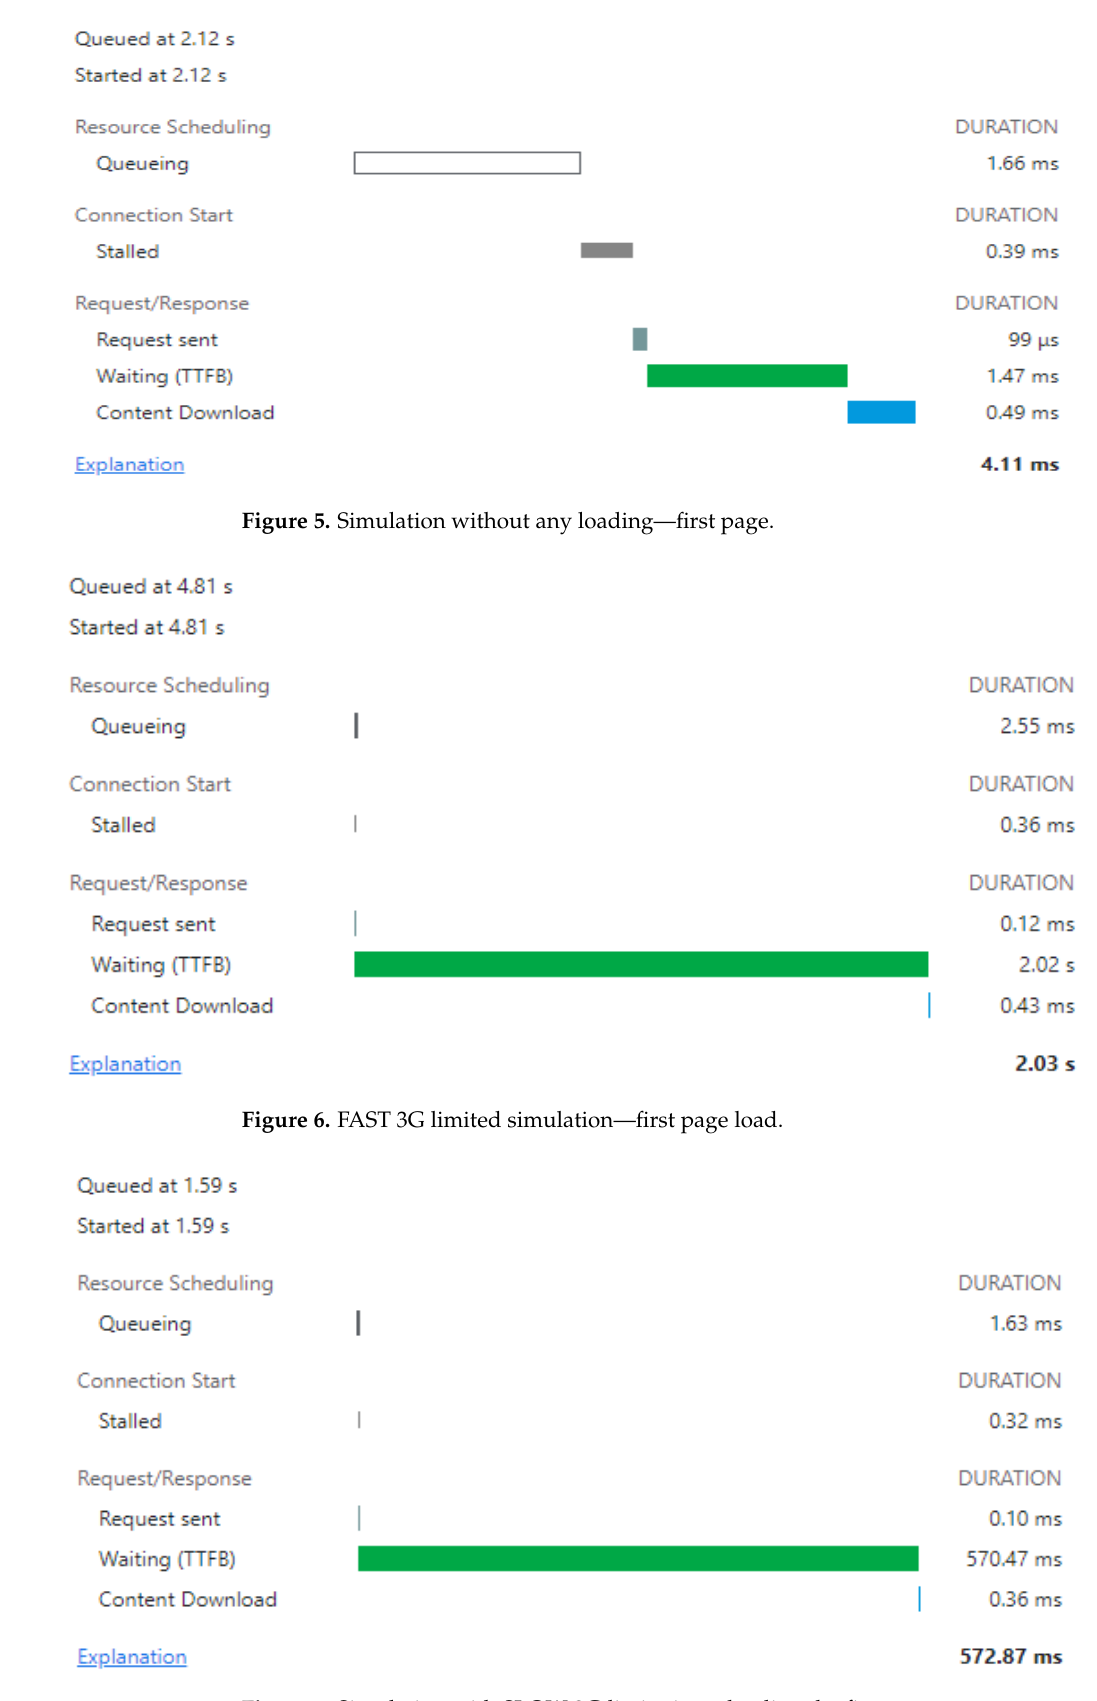
Figure 7. Simulation with SLOW 3G limitation—loading the first page.